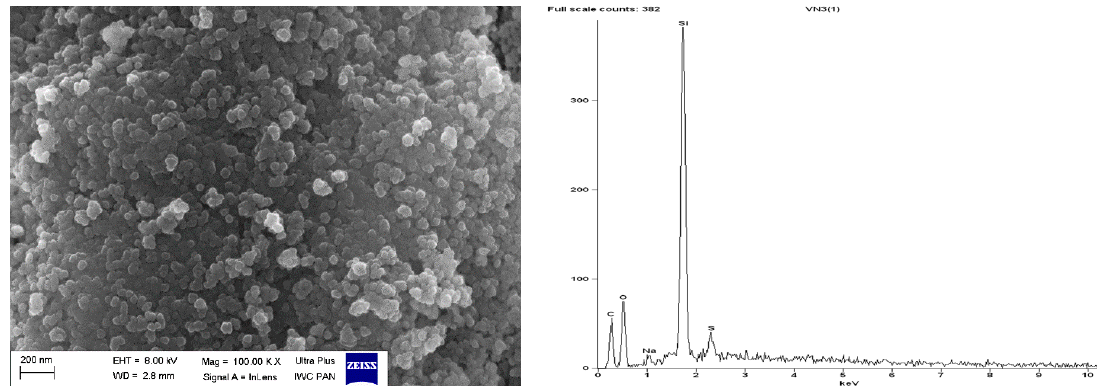
Figure 11. Scanning electron microscopy (SEM) with Energy-dispersive X-ray spectroscopy (EDS) analysis for pure VN3 silica.